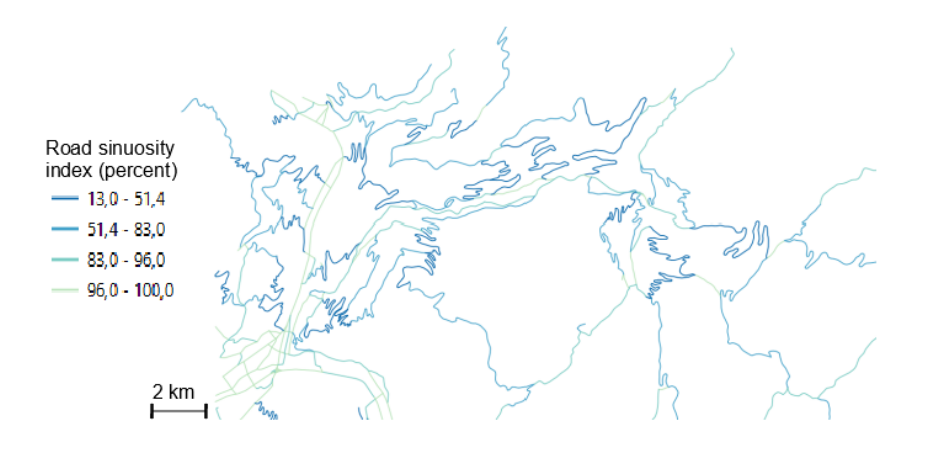
Figure 2. Sinuosity across generalised